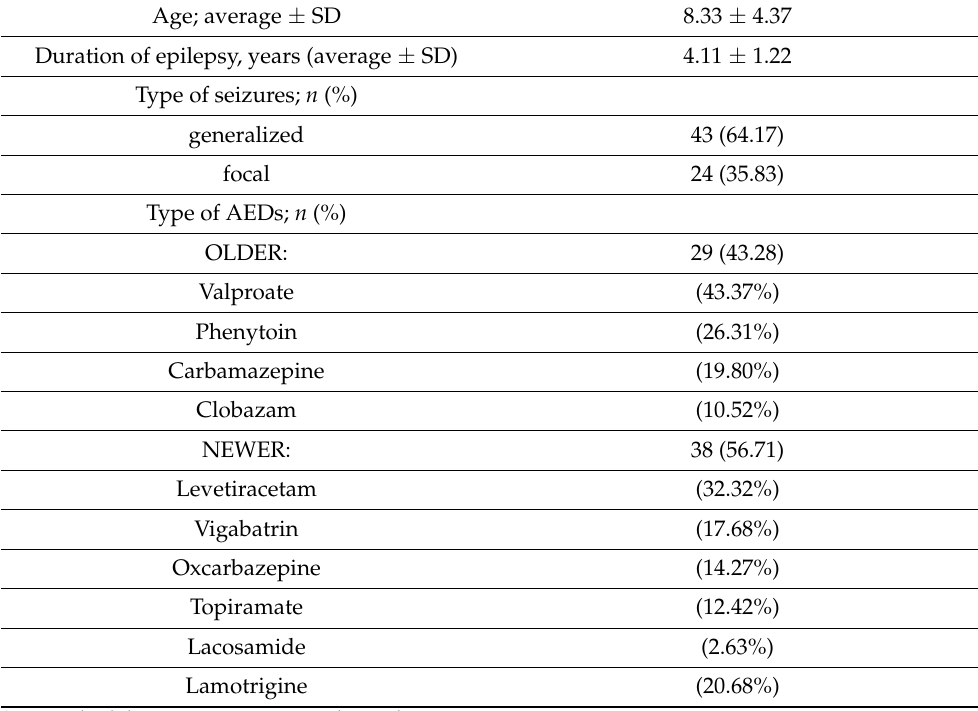
Table 1. Demographic and clinical data ( n = 67).